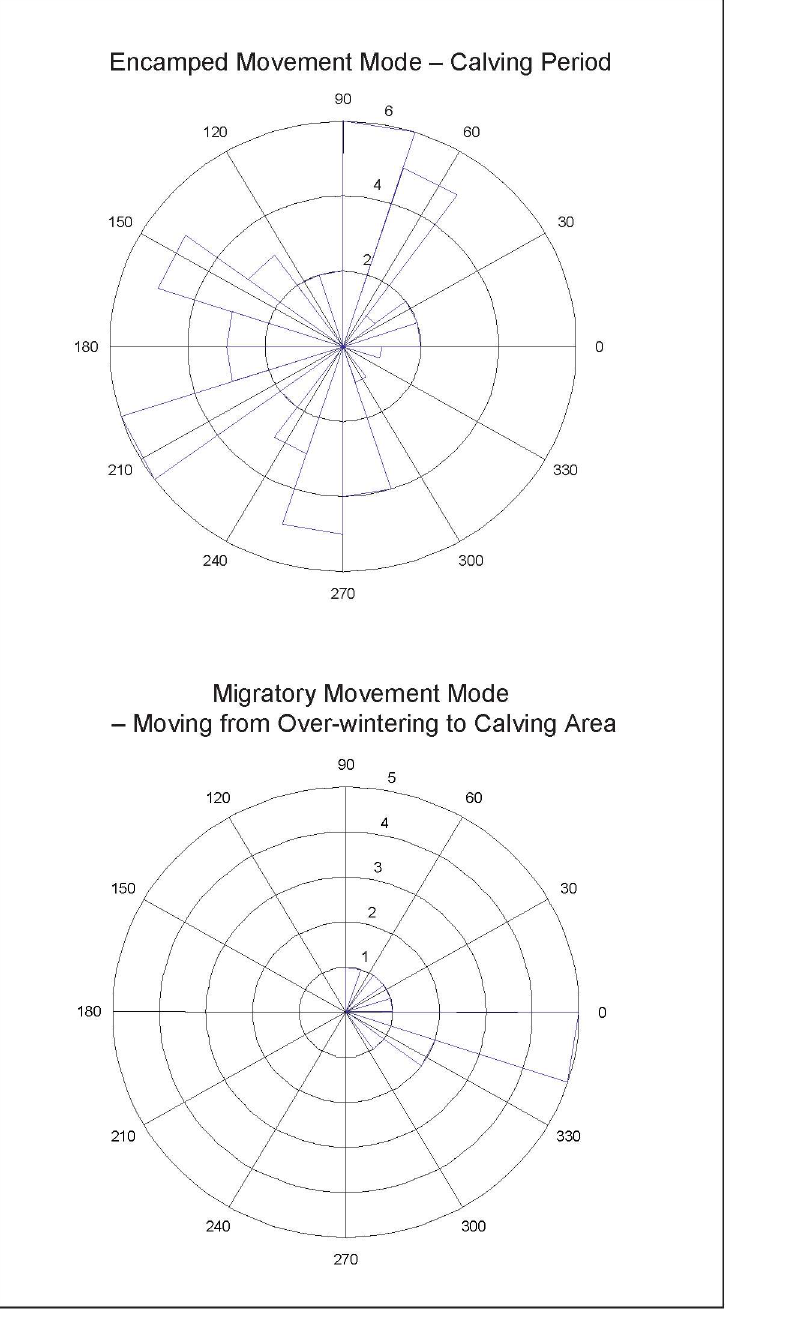
Fig. 2. A comparison of the turning angles of encamped movement behaviour ver¬ sus migratory movement behaviour. During periods of encampment when animals are staying within the calving or over-wintering areas they are making large turns, frequent reversals (i.e. turning 180 degrees) to stay in localized areas; whereas during periods of more nomadic movement in the spring and fall they are moving more directly rarely